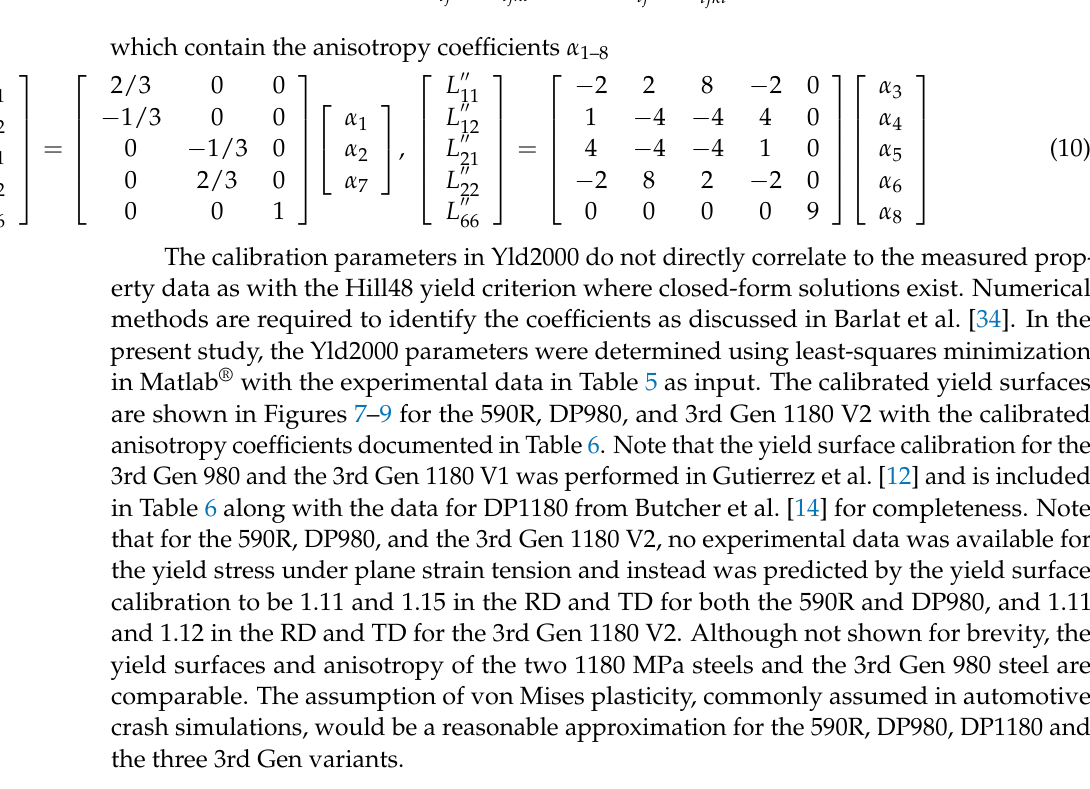
-1.25-0.75-0.250.250.751.25 Figure 7. Calibrated Barlat Yld2000 yield surface for the 590R ( a ) and predicted stress ratios ( b ). Figure 8. Calibrated Barlat Yld2000 yield surface for the DP980 ( a ) and predicted stress ratios ( b ).